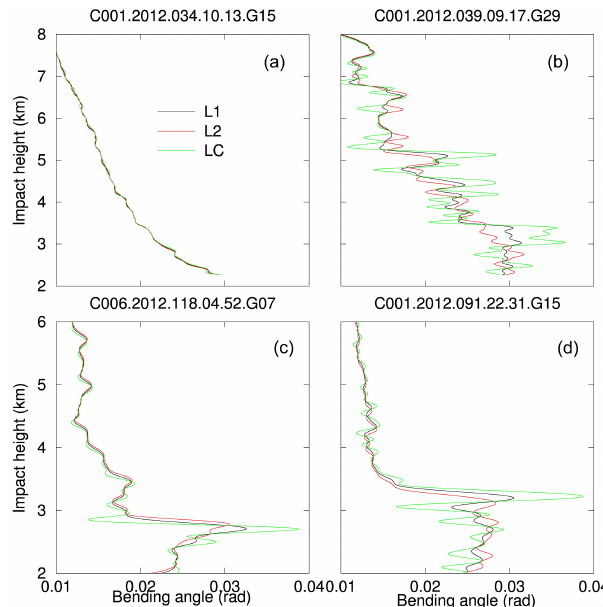
Figure 1. Examples of COSMIC L1CA (black), L2C (red), and ionosphere-free (green) bending angles in the